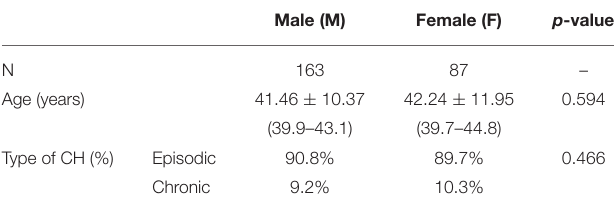
TABLE 1 | Demographic variables: comparison between